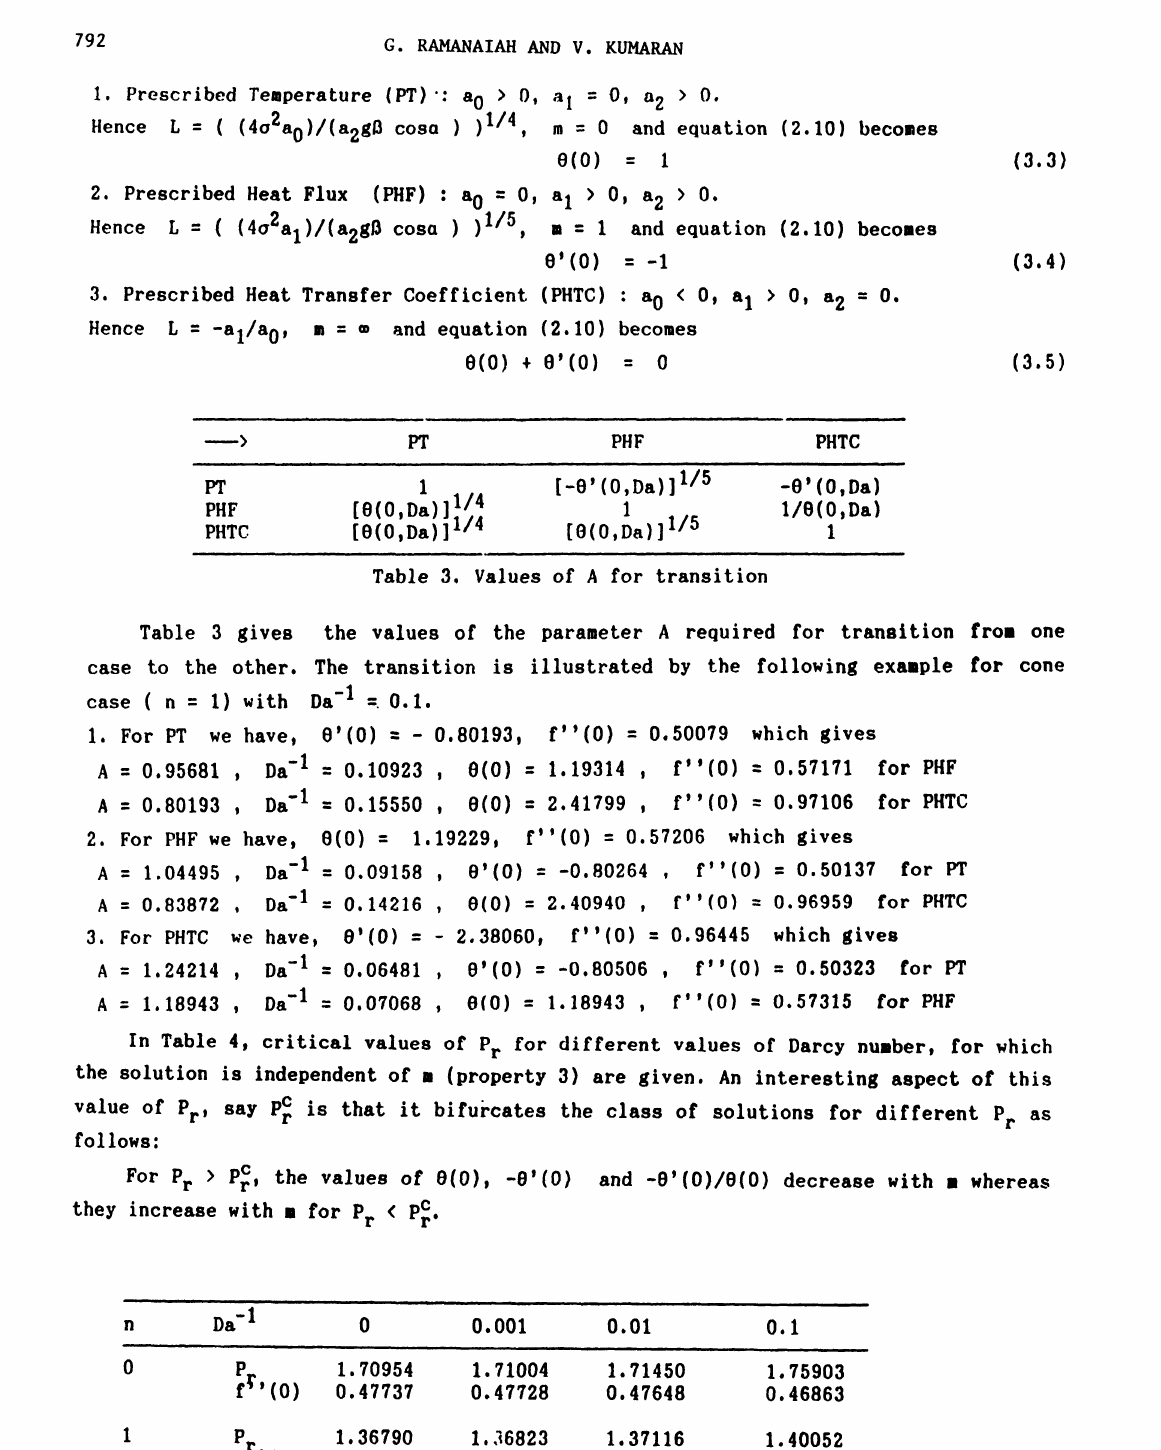
Table 4. Critical values of Pr for different Darcy